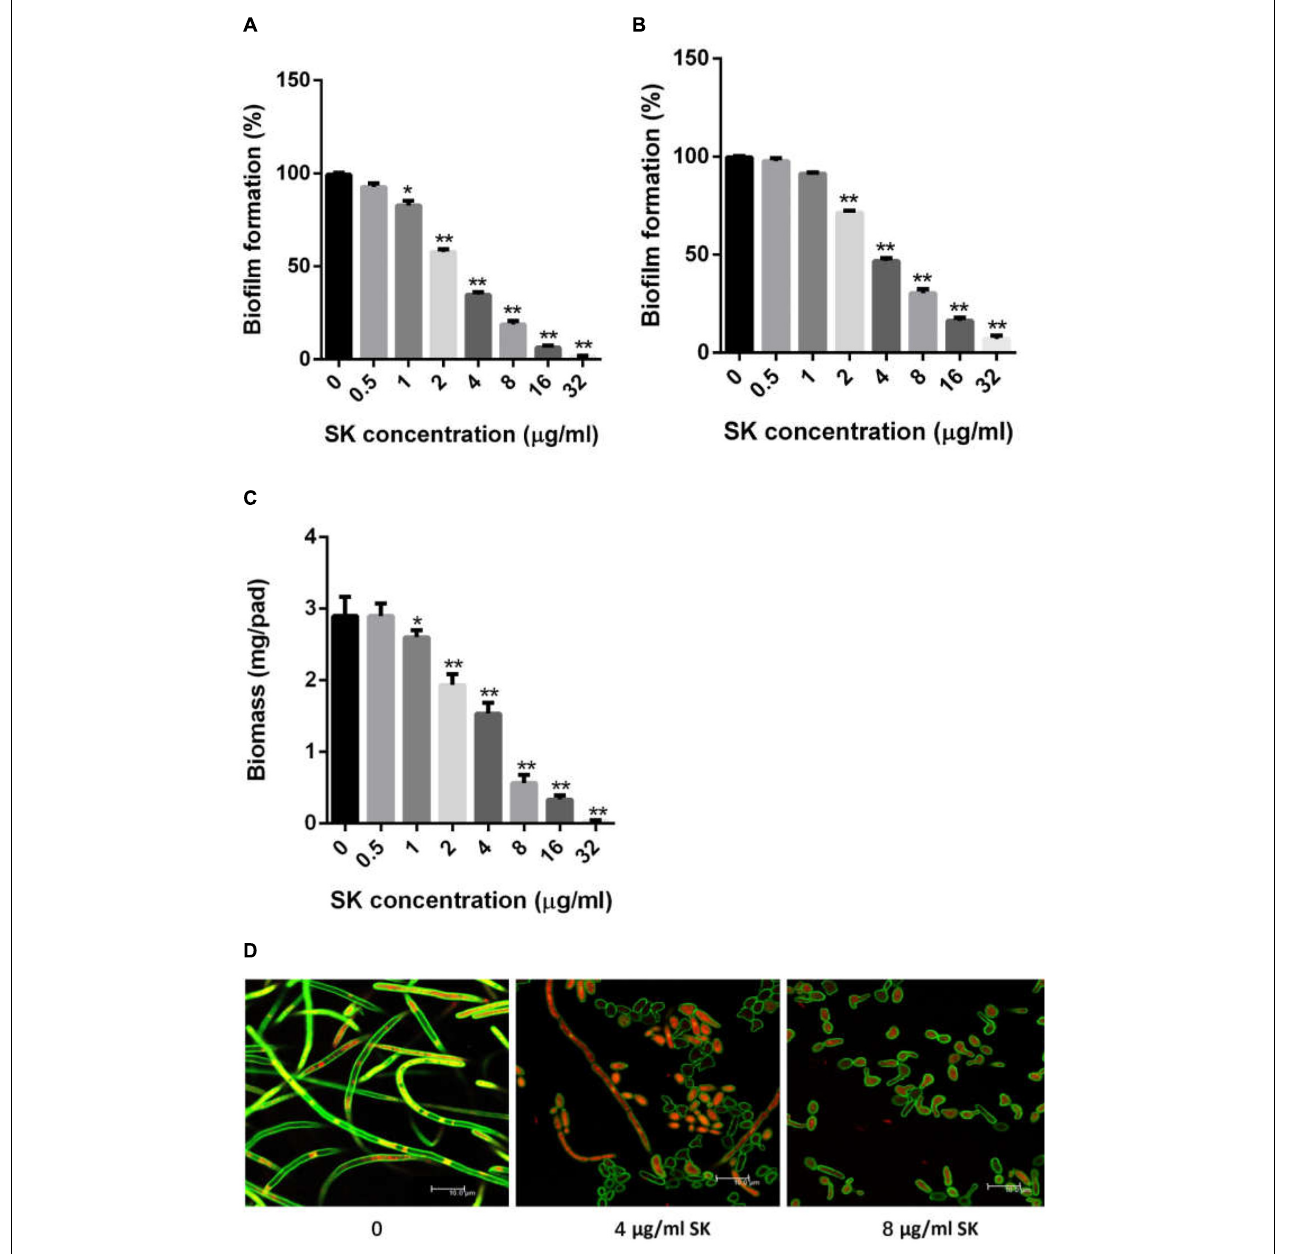
FIGURE 1 | SK inhibits C. albicans biofilms in vitro . (A) Effects of different concentrations of SK on biofilm formation. (B) Effects of different concentrations of SK on mature biofilms. (C) Effects of different concentrations of SK on biofilms formation determined by biomass production. (D) Effects of different concentrations of SK on biofilm formation, shown in CLSM images. Data are expressed as the mean ± standard deviation of the independent assays in triplicate. ∗ P < 0.05; ∗∗ P < 0.01 as compared to the SK-free